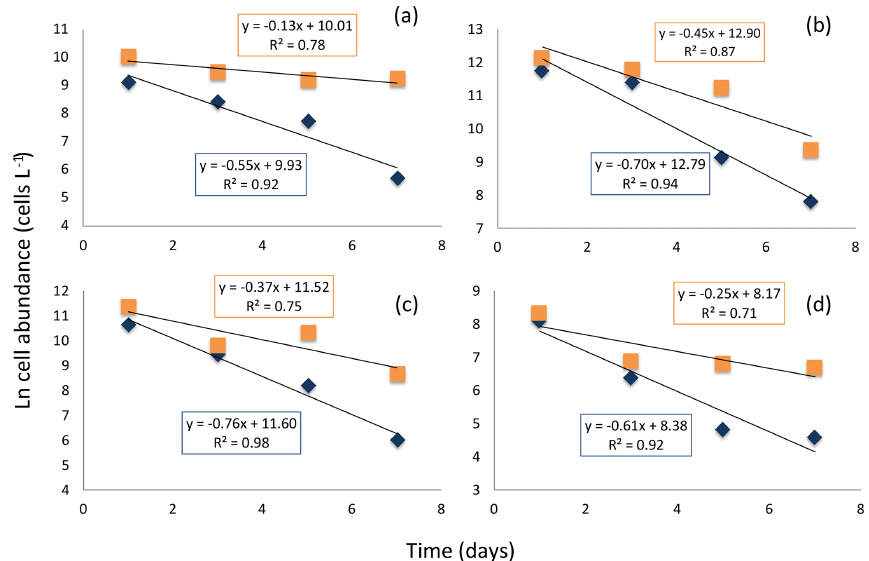
Figure 7. Decay in the cell abundance of living (blue diamonds) and total (orange squares) diatoms when exposed to aphotic zone light conditions. (a) Large-celled Thalassiosira spp. (b) Fragilariopsis spp. (c) Thalassiosira spp. (d) Pennate diatom. The solid black lines and equations show the fitted linear regressions for the percent of living cells (blue box, all fitted lines significant, p < 0 . 05) and total population cells (orange box, none of the fitted lines were significant, p > 0 .